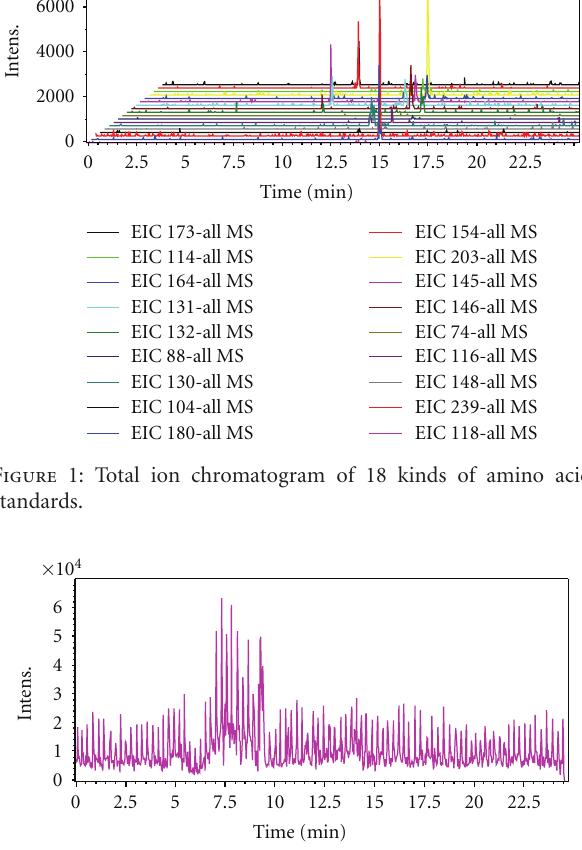
Figure 2: Total ion chromatogram of the urine of a patient with colorectal